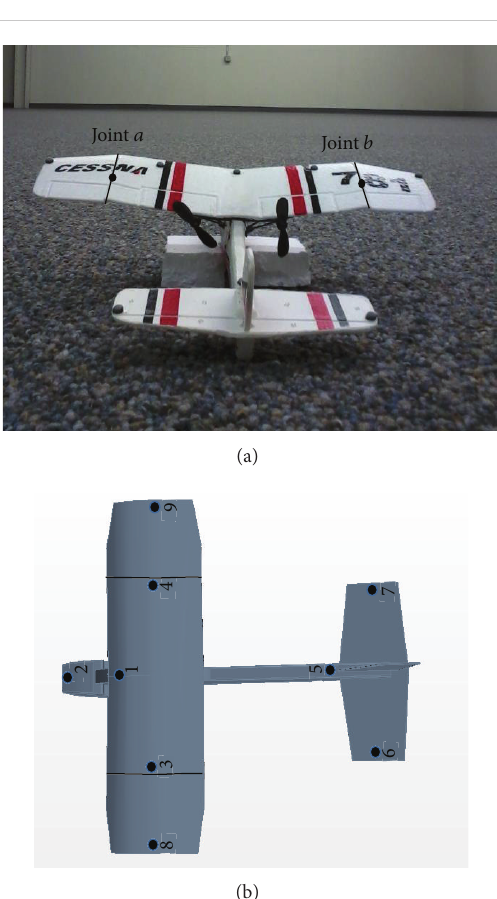
Figure 4: Rigid and articulated MAV models showing marker